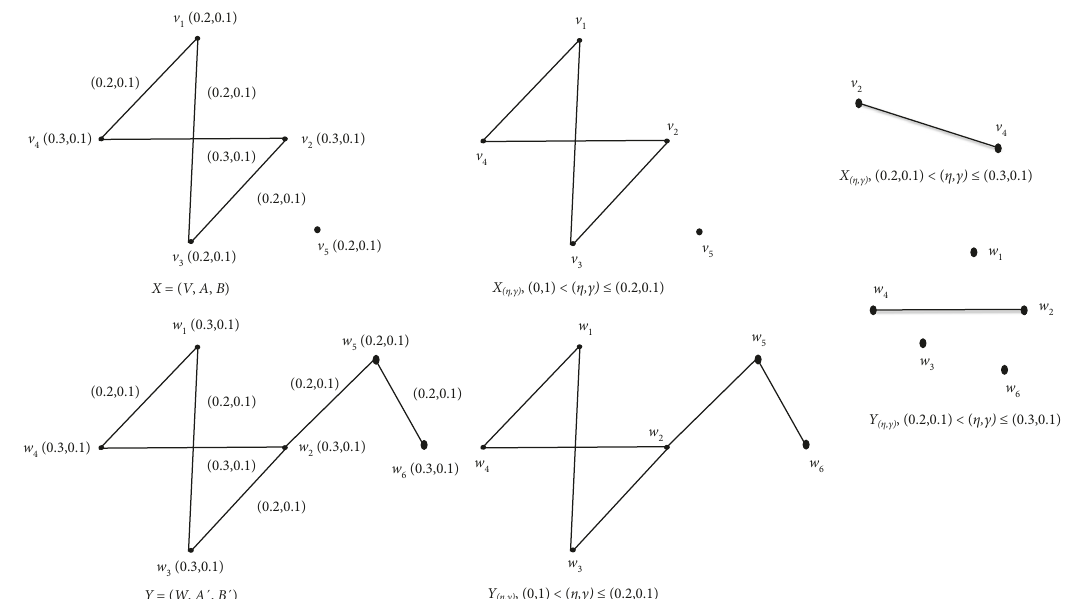
Figure 1: VGs X , Y and the mapping h : V